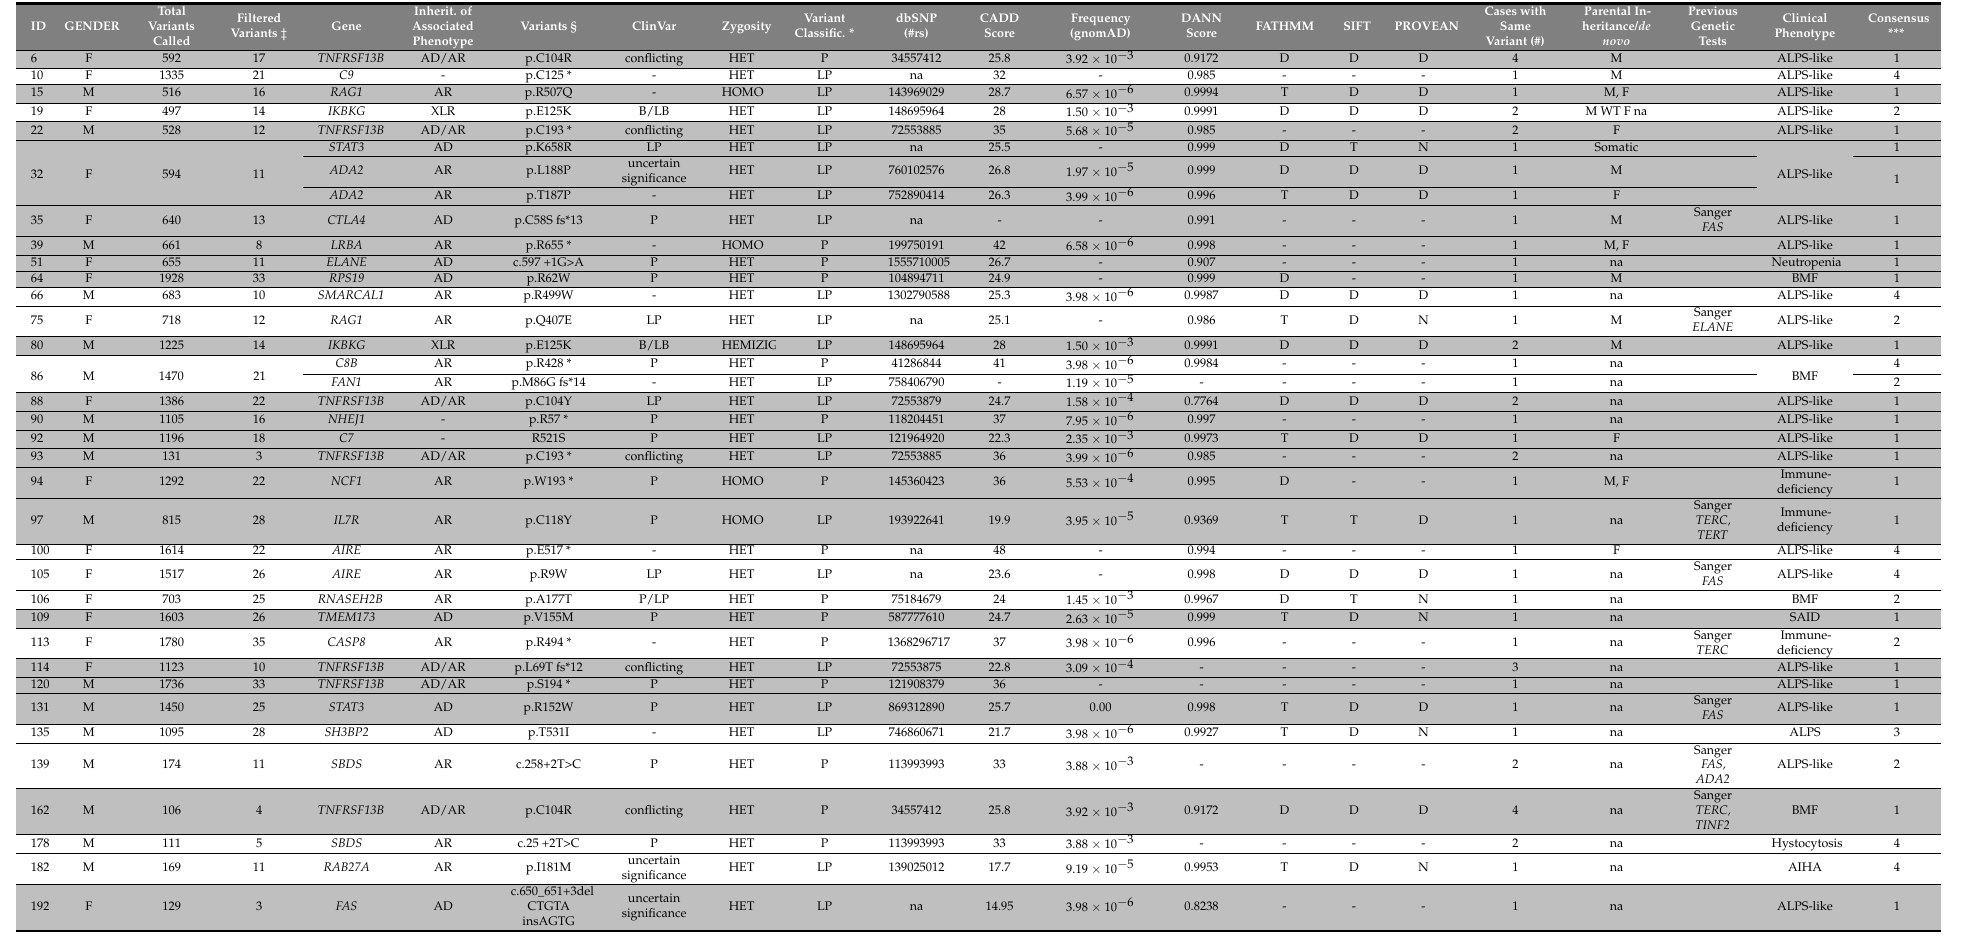
Table 1. Pathogenic and likely pathogenic variants detected among 272 patients affected with inborn errors of